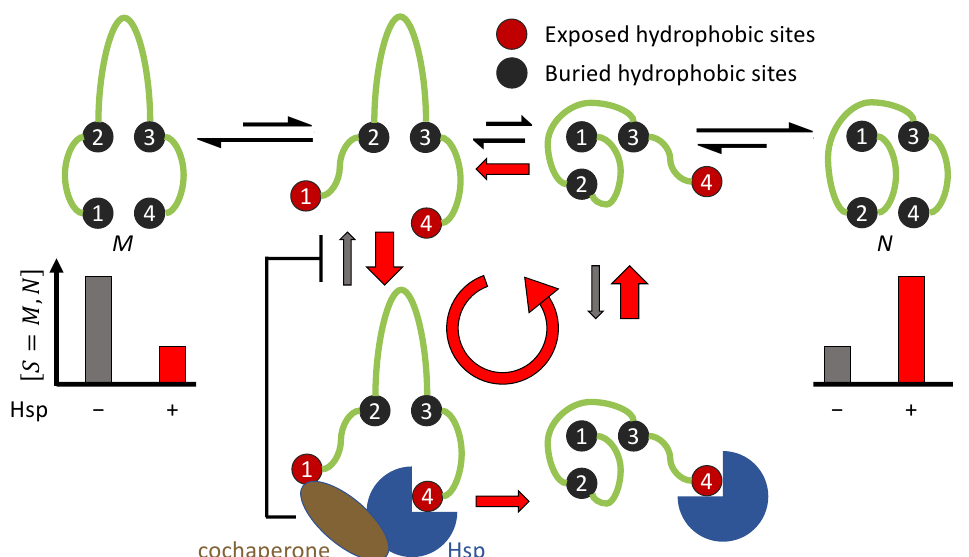
Figure 6. An ATP-driven chaperone (Hsp) may favor the protein folding pathway that exposes few cochaperone binding sites and drive the protein to a different conformation ( N ) than its most stable conformation ( M ) in the absence of the